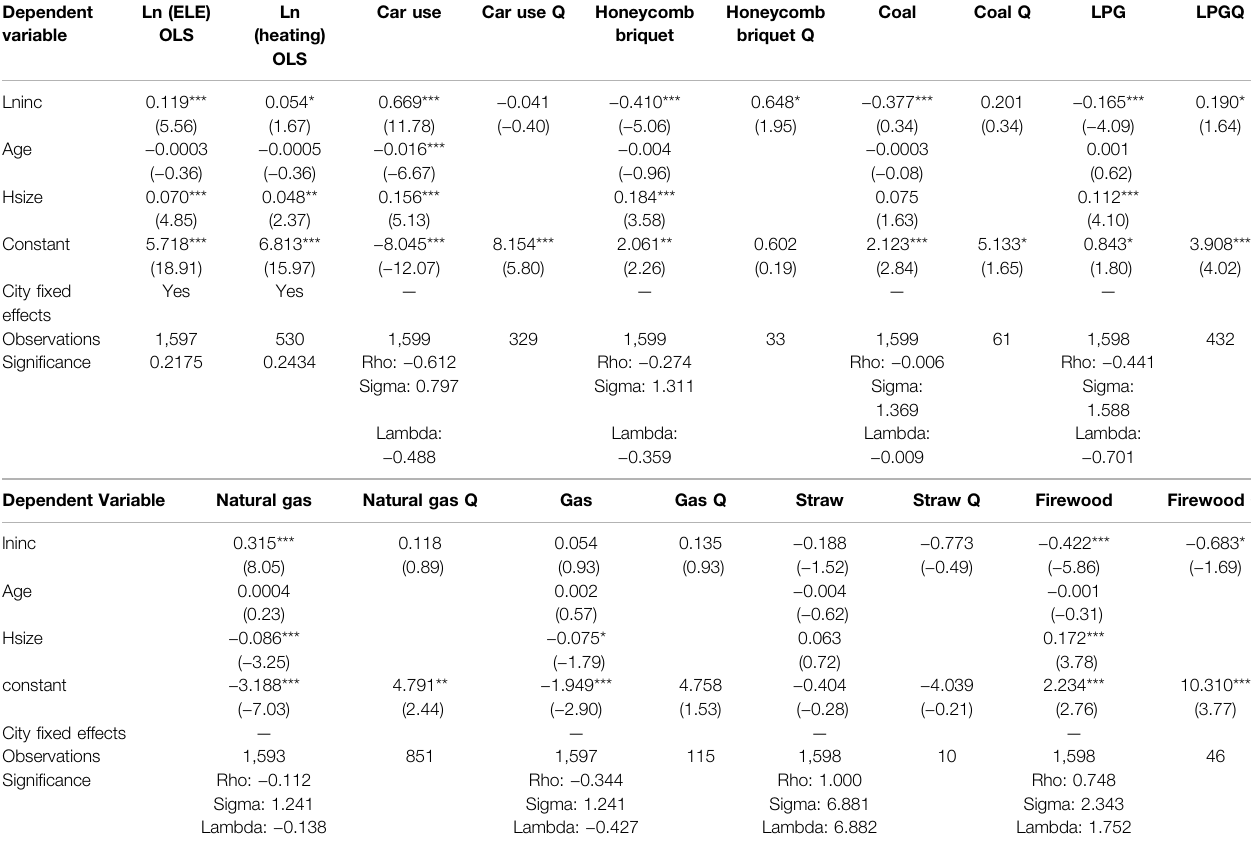
TABLE 3 | Regression results of household energy consumption.